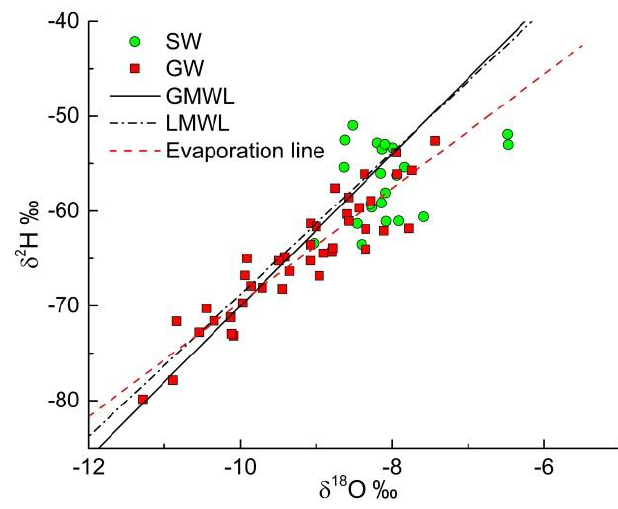
Figure 7. Relation betwee n δ 18 O and δ 2 H of the SW and GW in 2015 – 2016.